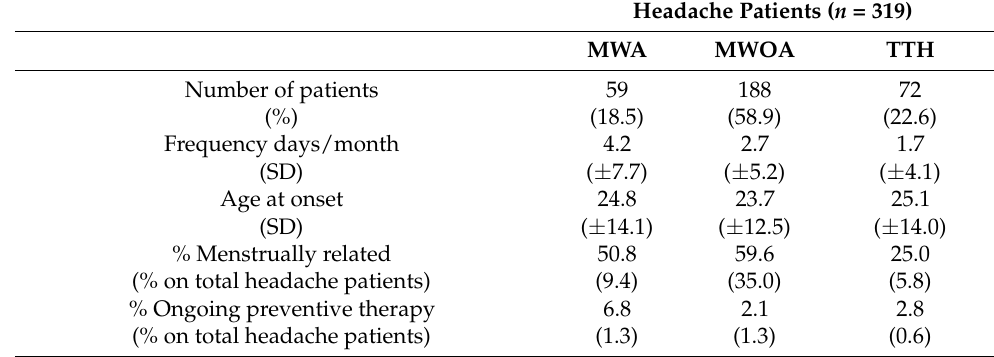
Table 3. Headache patients’ characteristics.